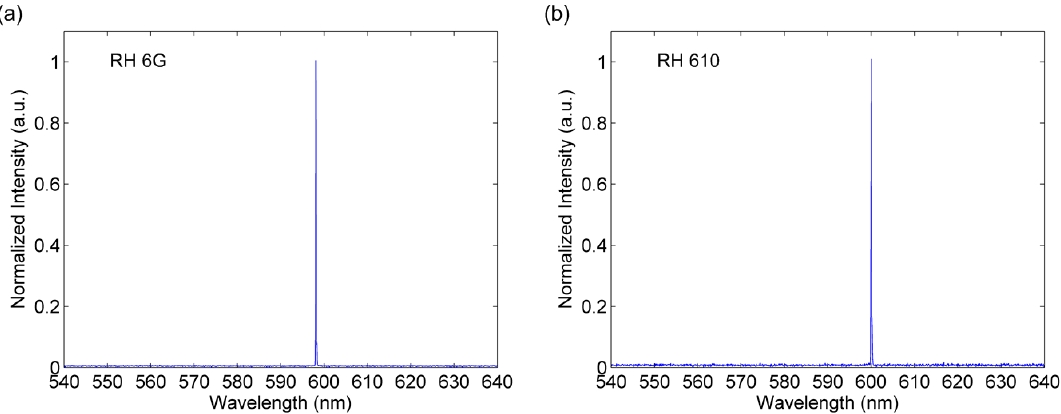
Figure 3. Typical emission spectra of DFB film dye lasers doped with ( a ) RH 6 G and ( b ) RH 610.